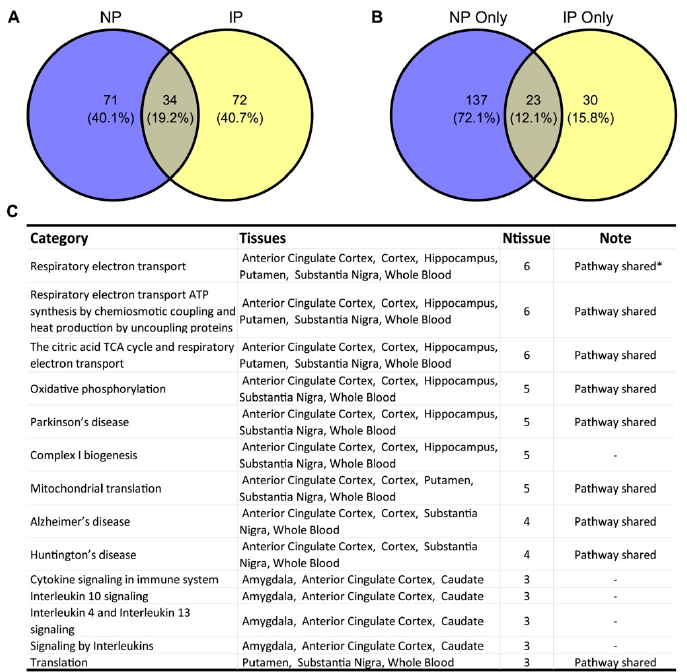
Figure 2. NP- and IP-associated co-expression modules and biological pathways are highly over- lapped. ( A ) Count of significant modules in NP and IP; ( B ) count of functional categories from NP- only and IP-only modules; ( C ) overlap of top functional categories by NP and IP modules. Only pathways that appeared in at least three tissues are shown. Ntissue: number of tissues with the category; * pathway shared: pathways were also indicated in condition-specific modules in both NP and IP, i.e., the overlapped categories in ( B ).